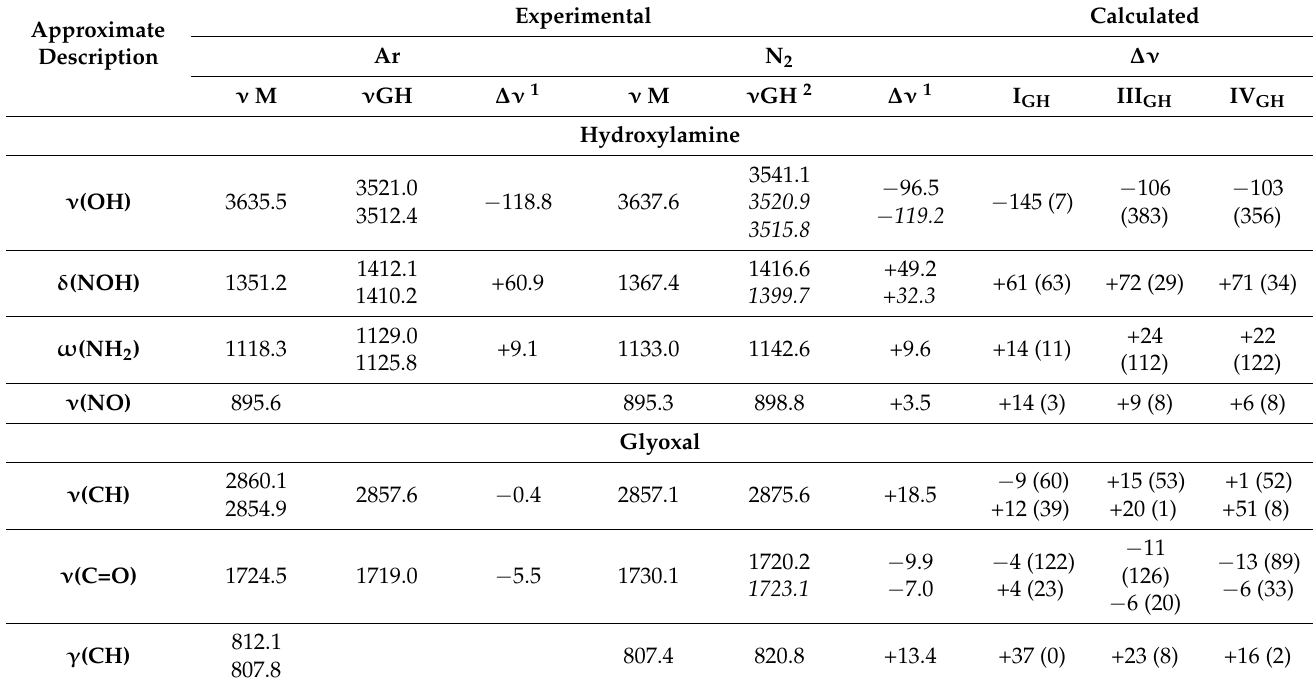
Table 2. The comparison of the observed wavenumbers (cm − 1 ) and wavenumber shifts ( ∆ ν = ν GH − ν M) for the CHOCHO– NH 2 OH (GH) complexes present in the Ar and N 2 matrices with the corresponding calculated values for the complexes I GH , III GH and IV GH . In parentheses, the calculated band intensities are given (km mol − 1